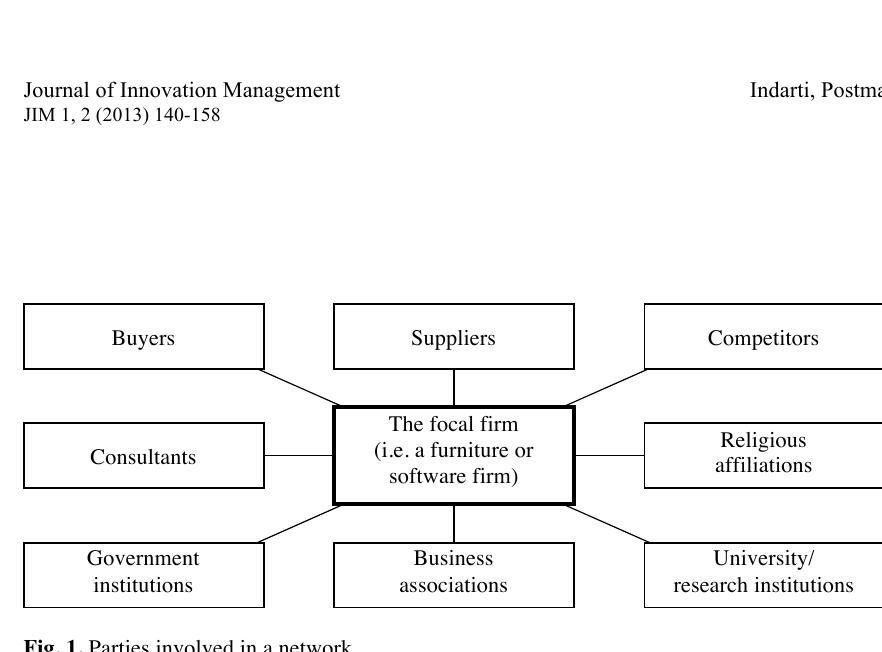
Fig. 1. Parties involved in a